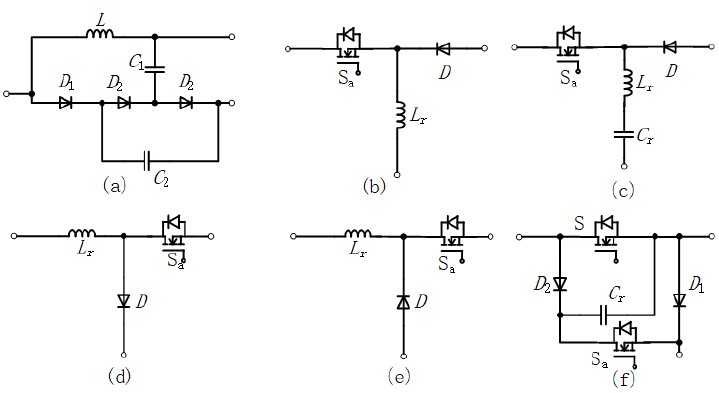
Figure 12. Soft-switching circuits. ( a ) PSC. ( b ) ZVTs. ( c ) ZCTs. ( d , e ) AST. ( f ) Active SCs.